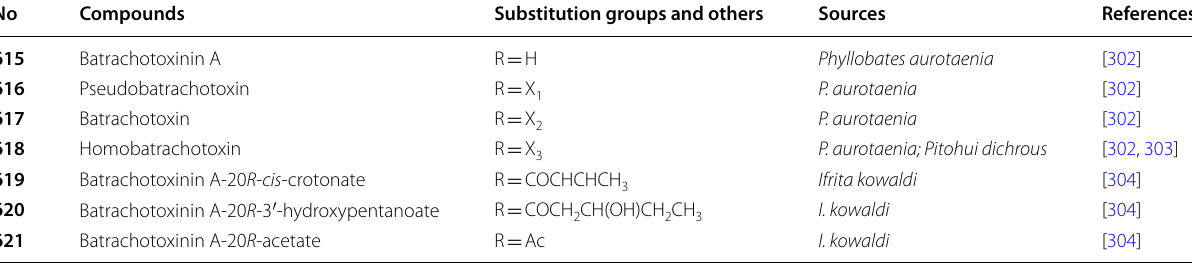
Table 13 Structures and sources of batrachotoxins 615–621